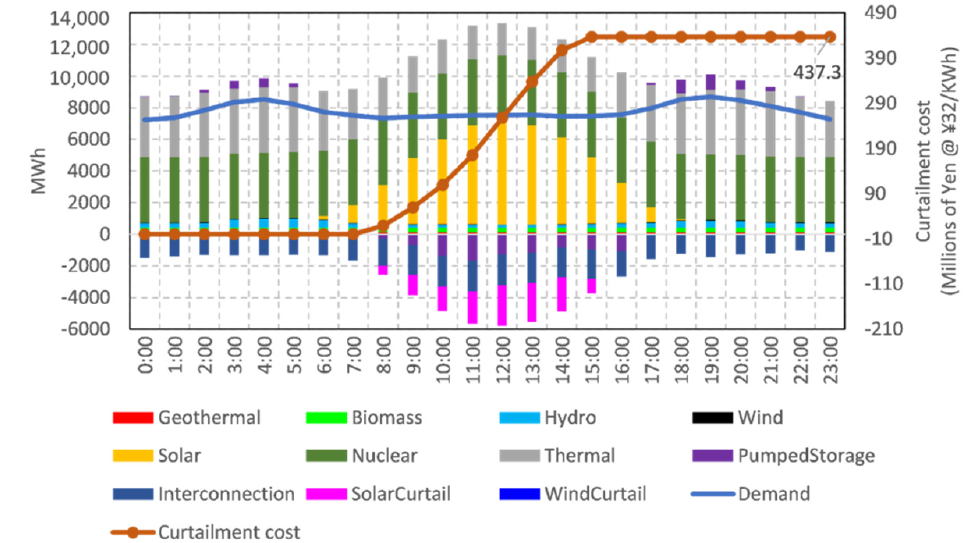
Figure 4. Highest curtailment day in Kyushu, 7 April 2019, showing the supply and demand balance with curtailment cost.